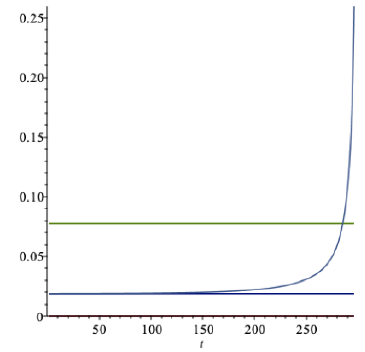
Figure 8. Recursive utility. Drawdown rate vs. return; γ > ρ